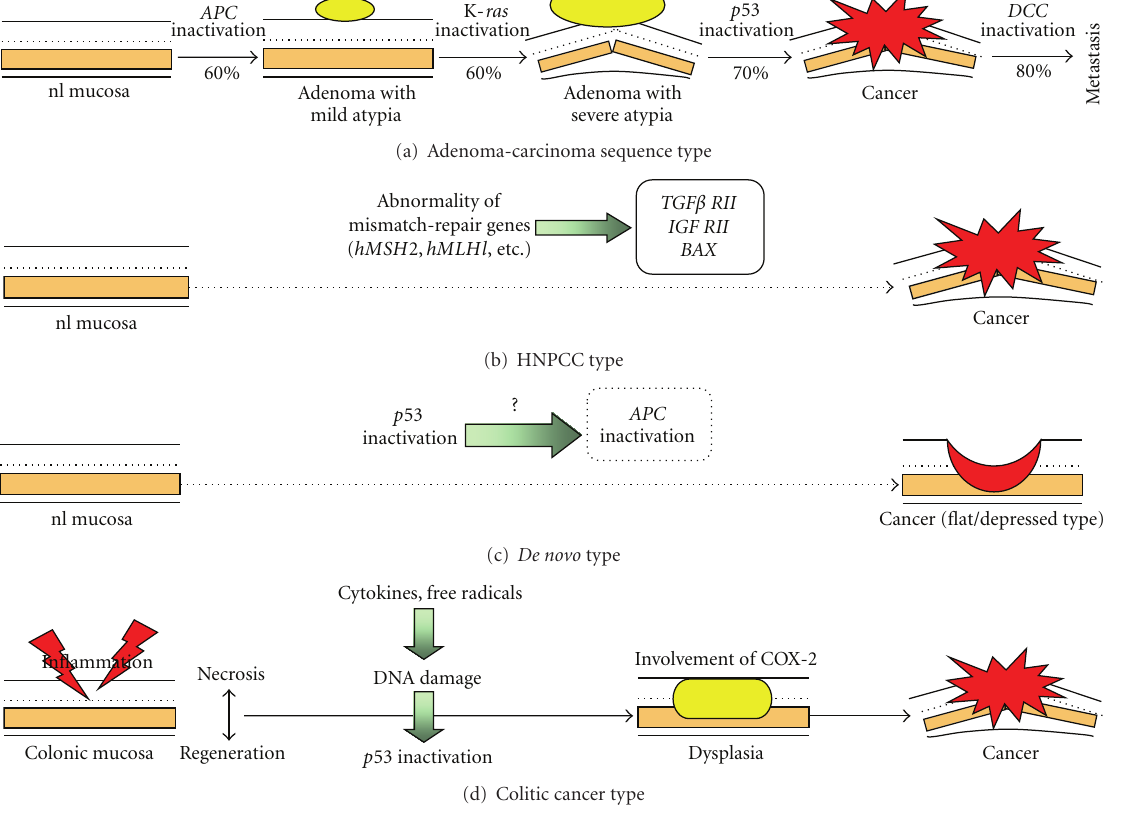
Figure 3: Carcinogenic steps of four types of human colorectal cancer.